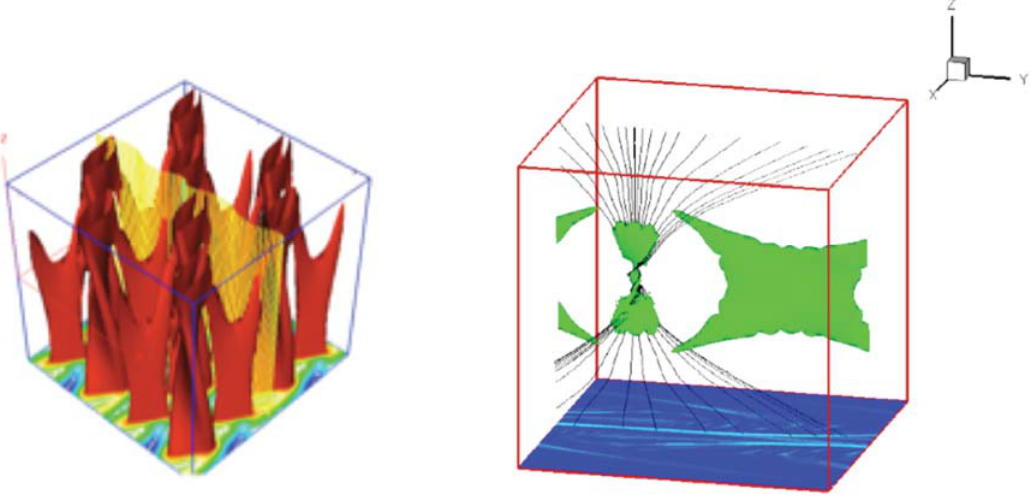
Figure 23. PHAETHON 3D MHD simulation. Left: Vertical current isosurfaces and sample magnetic field lines in a random force coronal heating simulation. Right: Current isosurfaces and representative magnetic field lines during a line-tied explosive instability